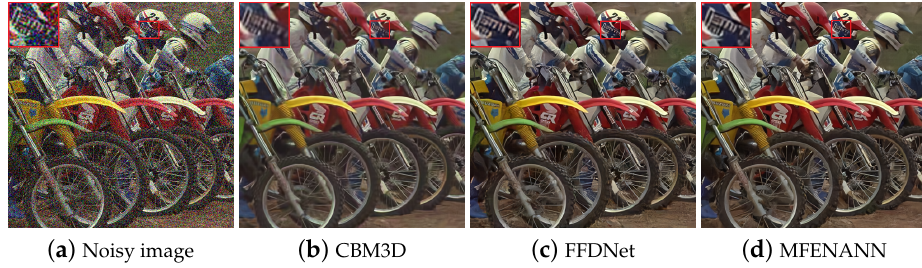
Figure 8. Experimental results of several state-of-the-art algorithms for image “kodim05” in “Ko- dak24” at a noise level of 50. The PSNR values are: ( a ) noisy image, 14.14 dB; ( b ) CBM3D, 24.29